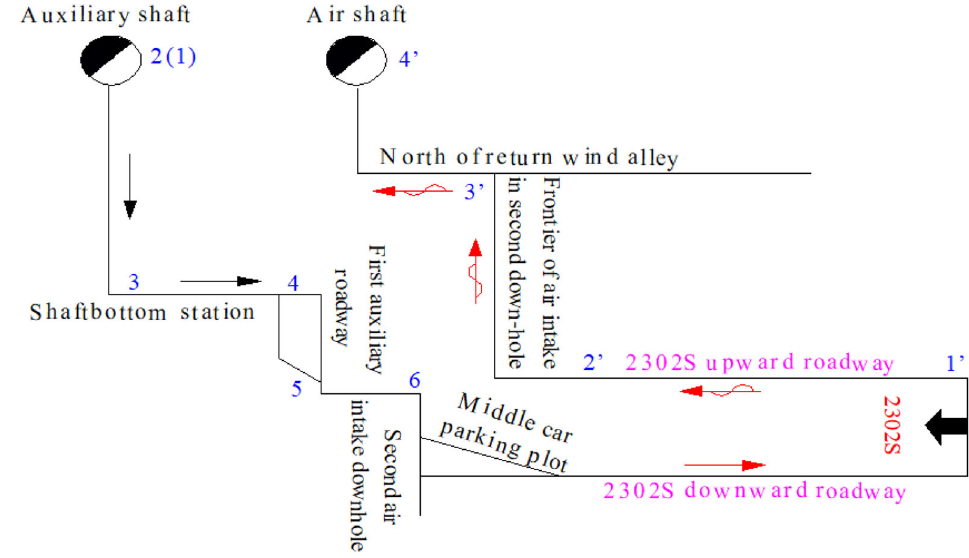
Fig. 1 Arrangement of measuring points (MPs; shown by blue numerals) on the main ventilation